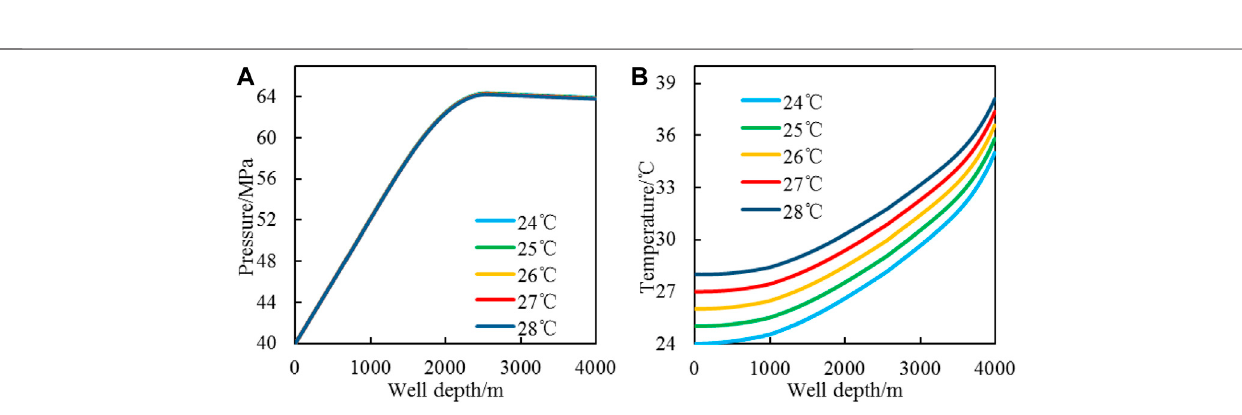
Frontiers in Earth Science |